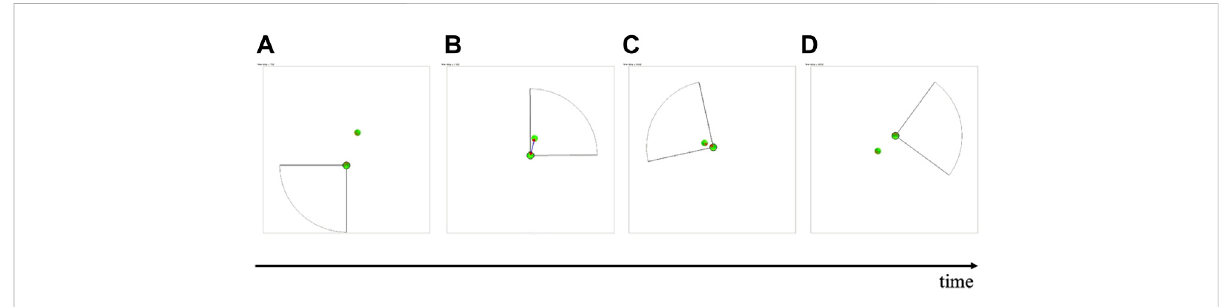
FIGURE 9 Snapshot of the simulation when N = 2. The fan-shaped observation range is shown for one of the agents. Two agents are connected by a line when K ij isabove the threshold K th . The probability distribution ofthe observation direction(Eqs. 6,7)isindicated by thecolor of each agent. Red and green denote the directions where the probability distributions are high and low, respectively.